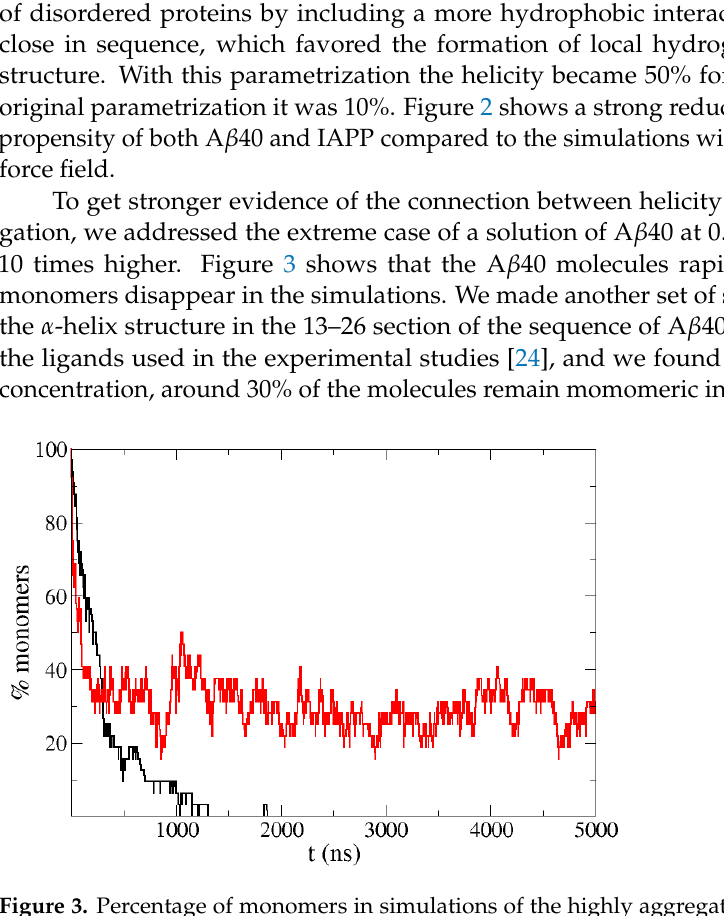
Figure 3. Percentage of monomers in simulations of the highly aggregating peptide A β 40 at very high concentration (0.3 mM) with the normal PACSAB force field parametrization (black line) and when α -helix structure is restrained in the 13-26 section of the sequence of A β 40 (red